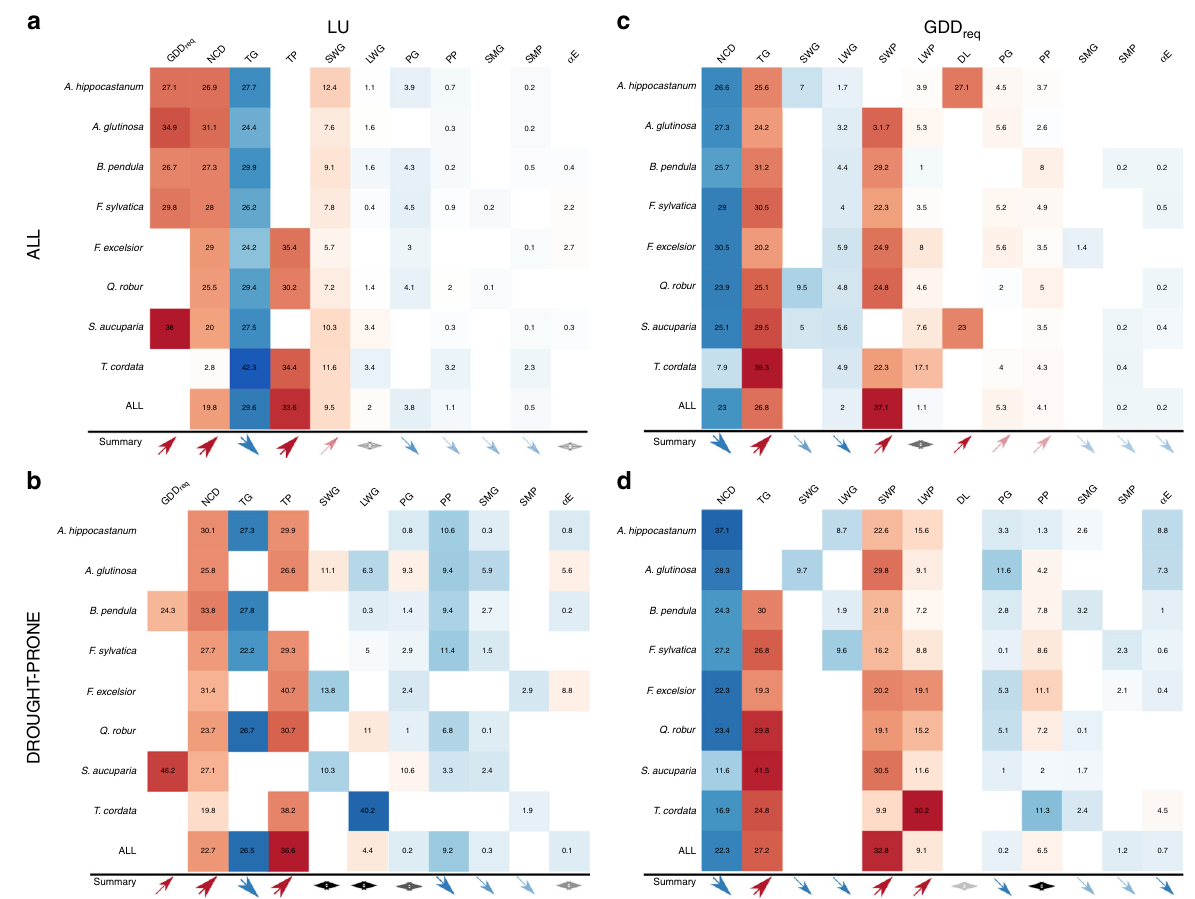
Fig. 2 Effect and direction of background climate on LU and GDD req for each species. Relative importance of each variable (in percentage) in explaining leaf unfolding date (LU) and corresponding heat requirement (GDD req , estimated as the sum of temperatures > 5 °C between 1 January and the LU date) for each species considering ( a – c ) all sites, ( b – d ) only drought prone sites. The sum of each row is equal to 100% of model R². Red colors indicate a positive correlation, while blue colors indicate a negative correlation. Color intensity re fl ects variable relative importance. Blanks represent variables that were discarded during the predictors selection. See caption of Fig. 1 for the description of each variable and Table 1 for samples size. The direction and importance of correlations among species is summarized by the size and color of arrows at the bottom of each panel. A double black arrow means that the direction of the response is species dependent. See Supplementary Tables 5 – 10 in appendix for a complete description of correlation coef fi cients.